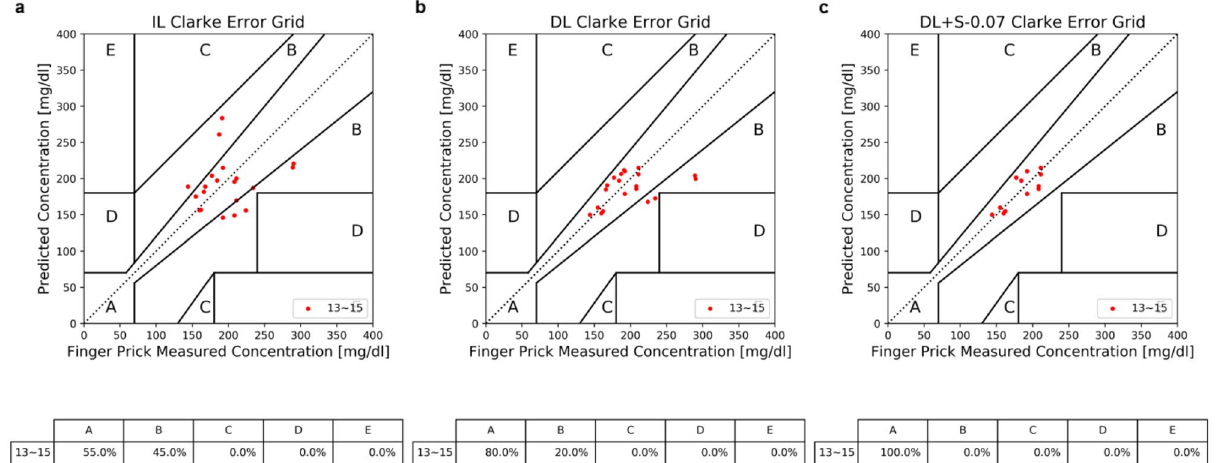
Figure 5. Predictions of rounds 13–15 (each paired with round 12) by models built with a dozen rounds of training data (rounds 1–12) for (a) IL, (b) DL, and (c) DL +